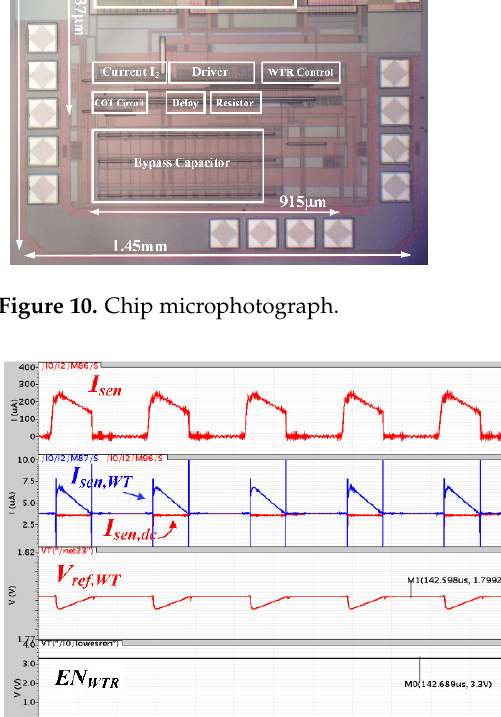
Figure 11. Simulated waveforms of the tracking reference generator.